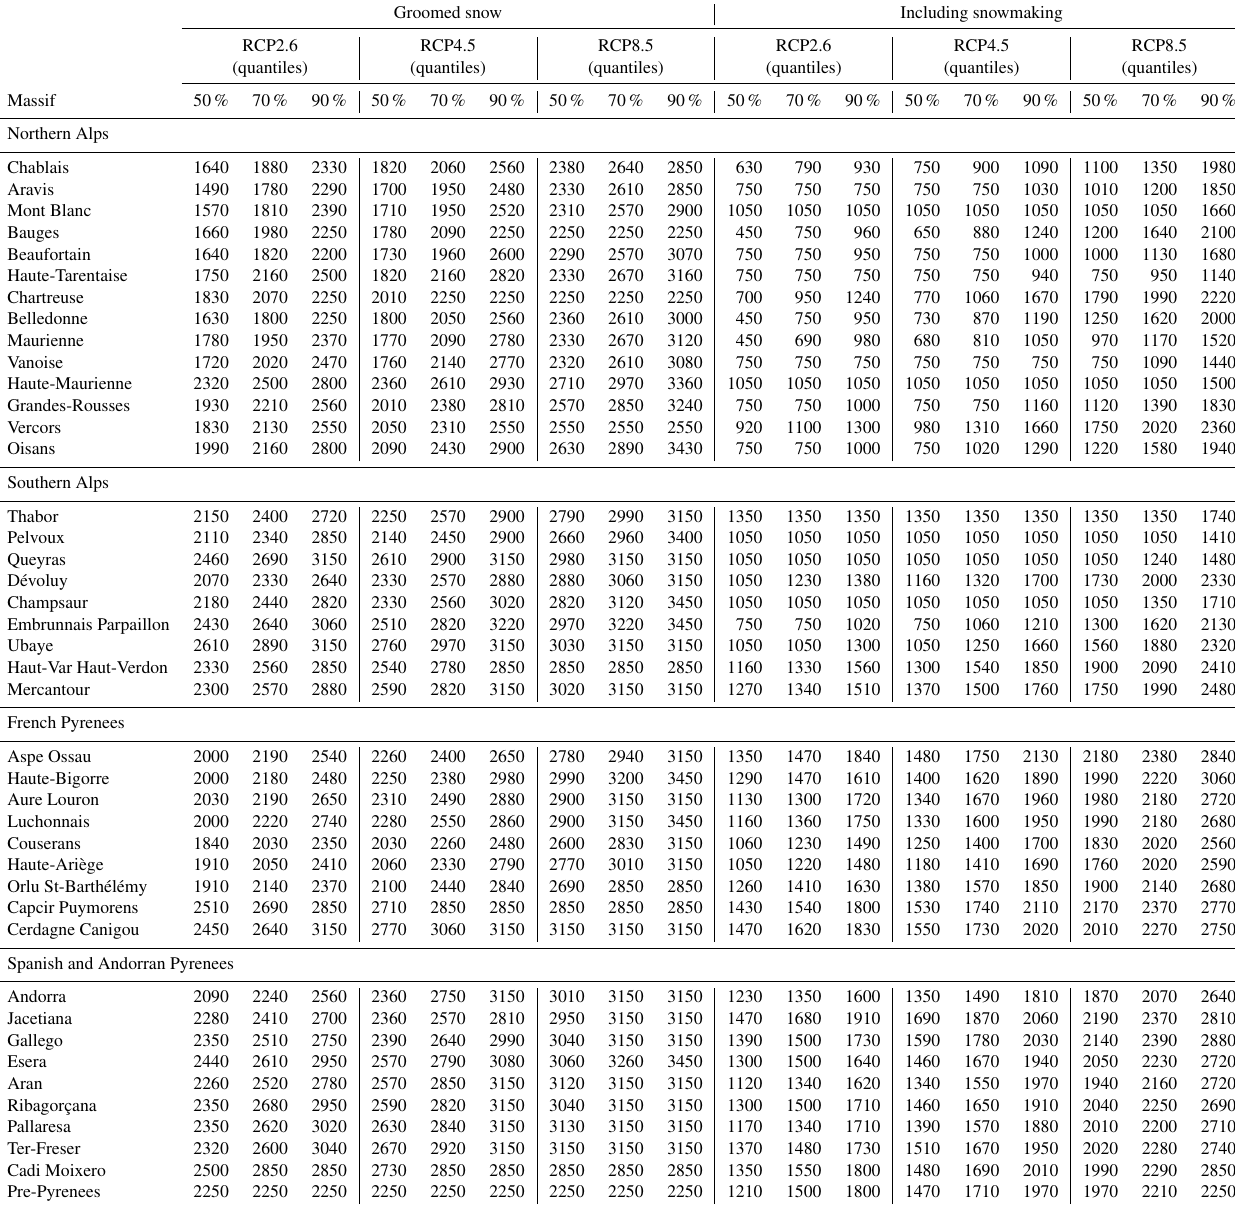
Table A3. Snow reliability elevation for the end of the century (2080–2100) for the 42 massifs distributed over the northern Alps, southern Alps, French Pyrenees, and Spanish and Andorran Pyrenees, computed by climate models for the RCP2.6, RCP4.5 and RCP8.5 and for three reliability requirements (50%, 70% and